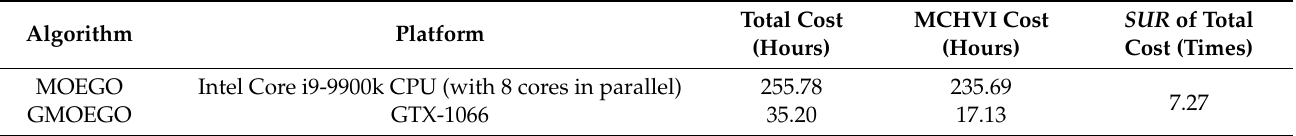
Table 4. Speedup results of MOEGO and GMOEGO